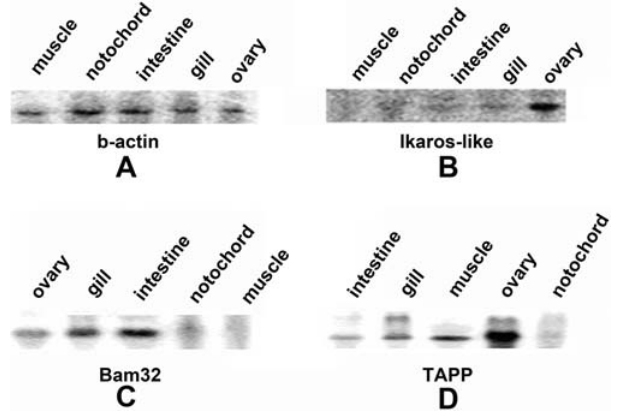
Figure 10. Nouthern blot analysis. Total RNA from muscle, notochord, intestine, gill and ovary of amphioxus were 20ug in each lane. (A) amphioxus b-actin. (B) amphioxus Ikaros-like. (C) amphioxus Bam32. (D) : amphioxus